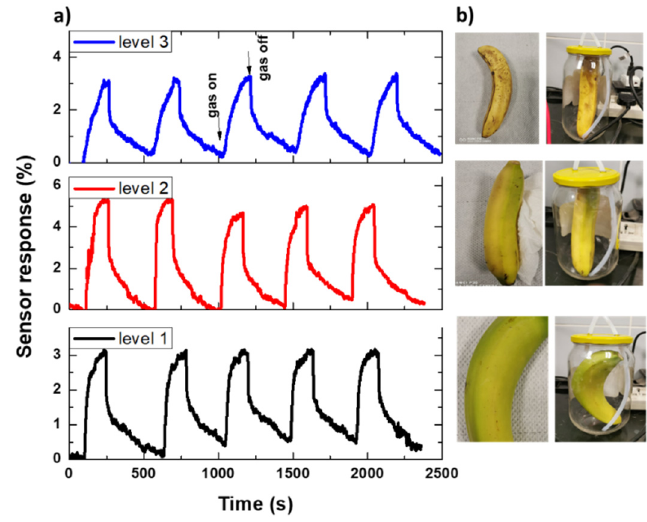
Figure 15. ( a ) A repeated sensor signal (five cycles) for ( b ) different bananas at different ripening levels.